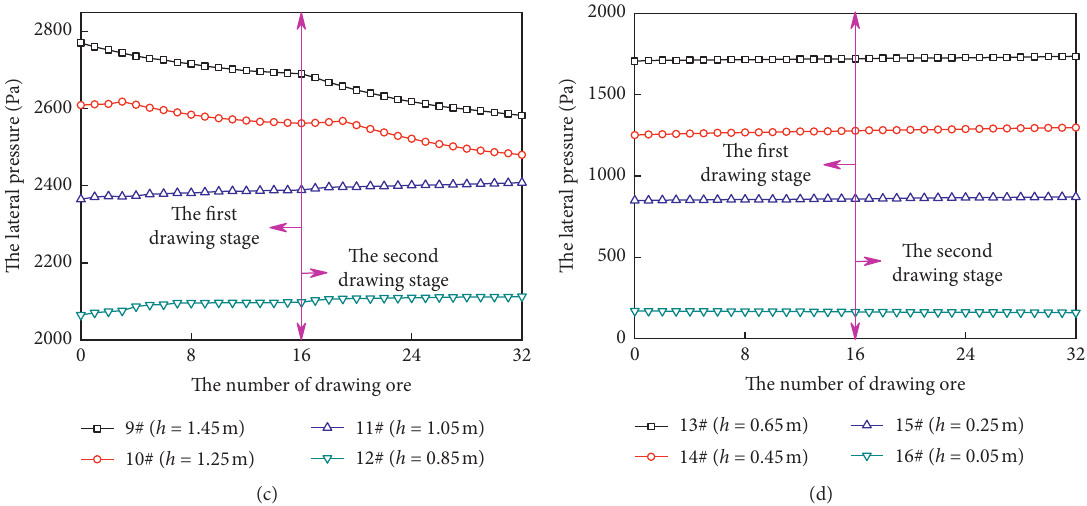
Figure 10: The relationship between the number of drawing ore and the values of lateral pressure with scheme 7.